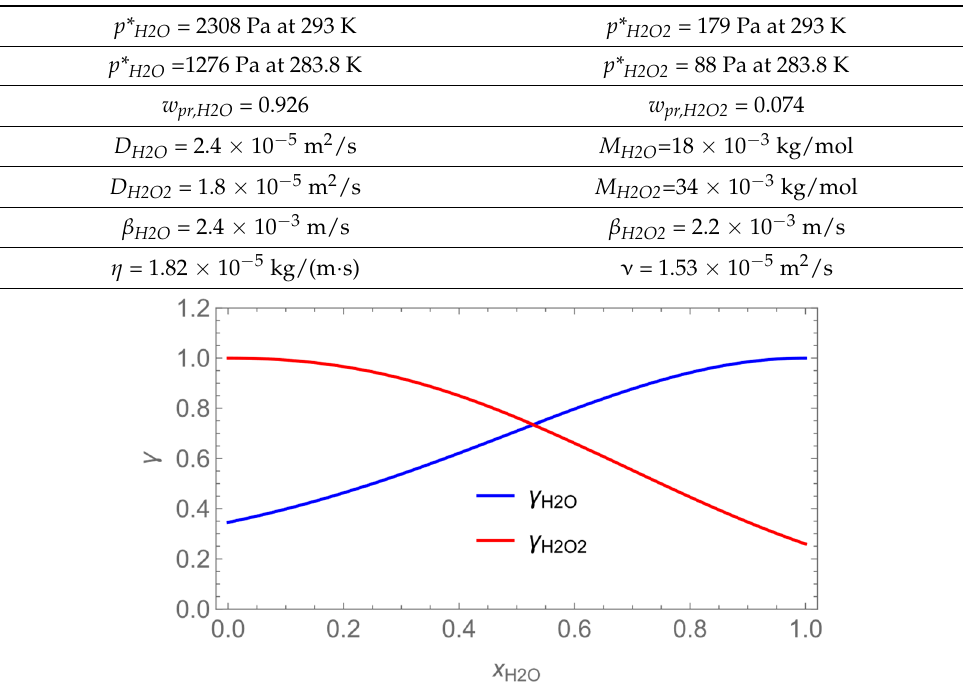
Table 2. Substance-specific input parameters.